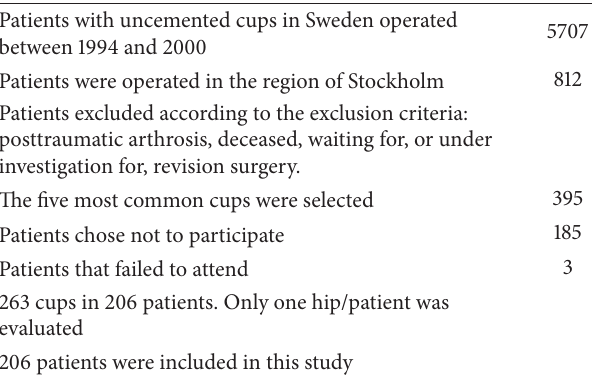
Table 1: Patient